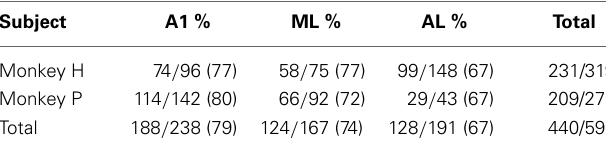
Table 1 | Population of auditory neurons driven by pure tones (PT) in different subfields of auditory